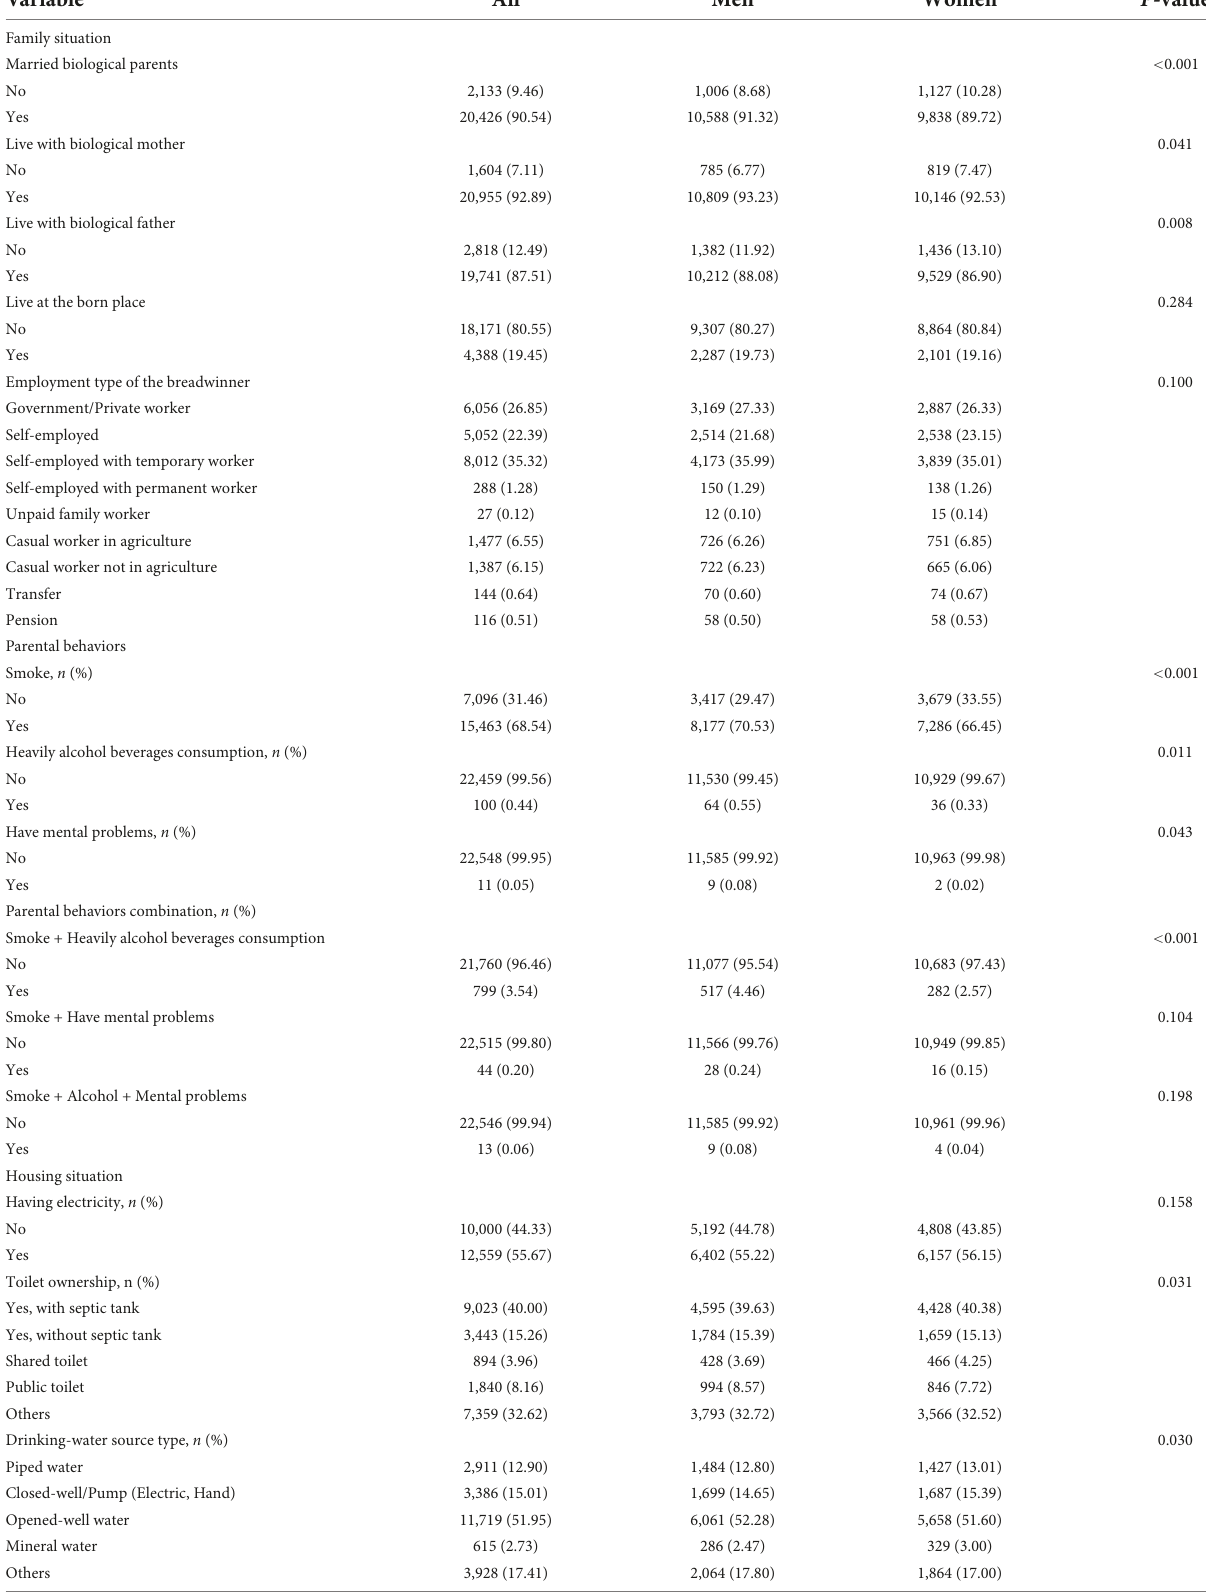
TABLE 2 Distribution of childhood socioeconomic status.